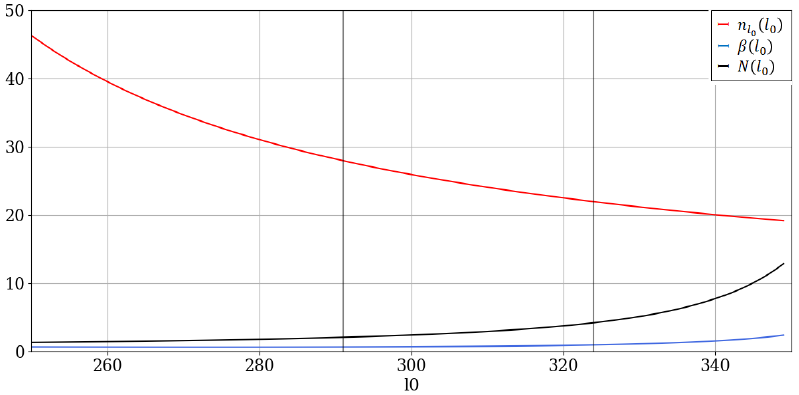
,𝛽,𝑁 as functions of 𝑙 0 : 𝑙 0 between 250 and 350 m , with a fixed 𝑙 1 = 200 m and Figure 7. 𝑛 𝑙 0